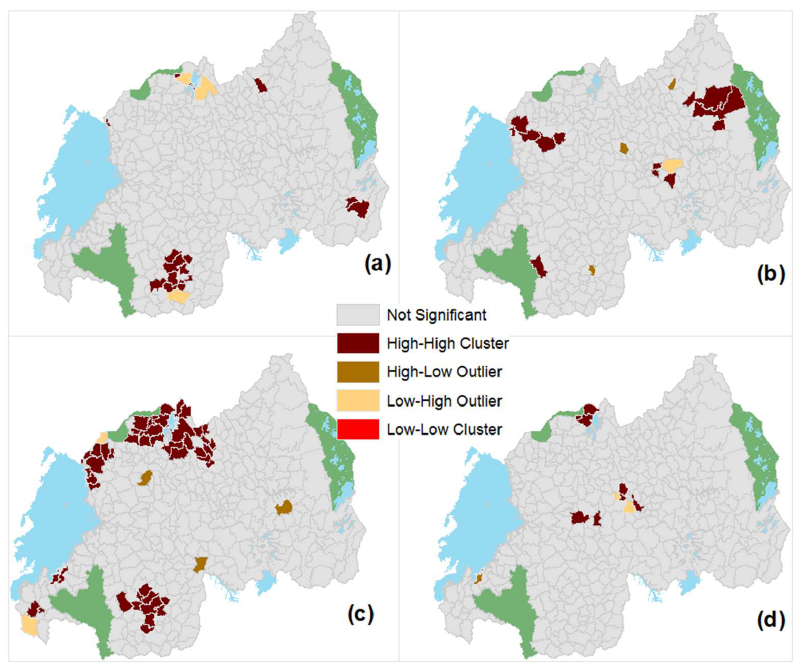
Figure 5. Spatial distributions of Anselin local Moran’s I at the HFSA level, for ( a ) combined STH cases; ( b ) T. trichiura ; ( c ) A. lumbricoides and ( d ) hookworm.